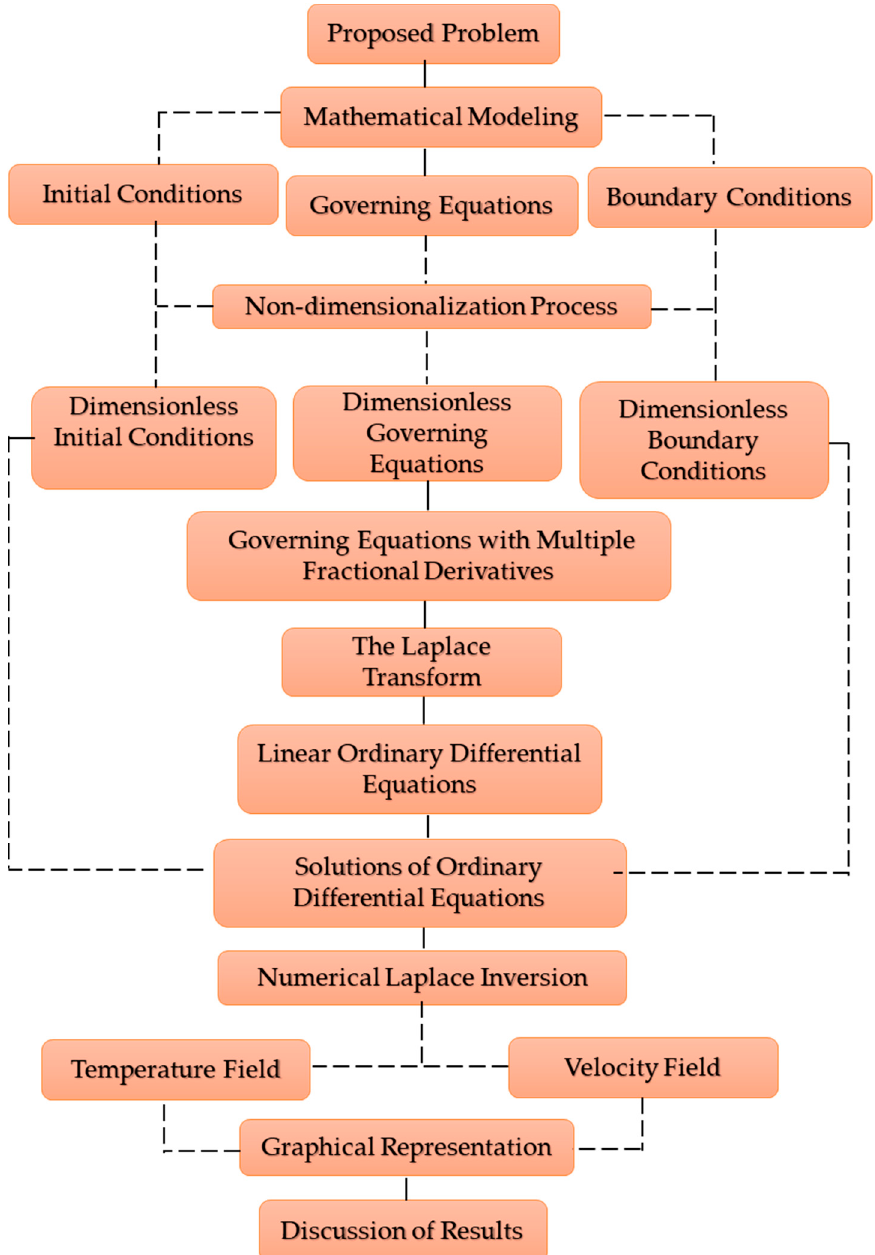
Figure 2. Solution methodology and operational framework.